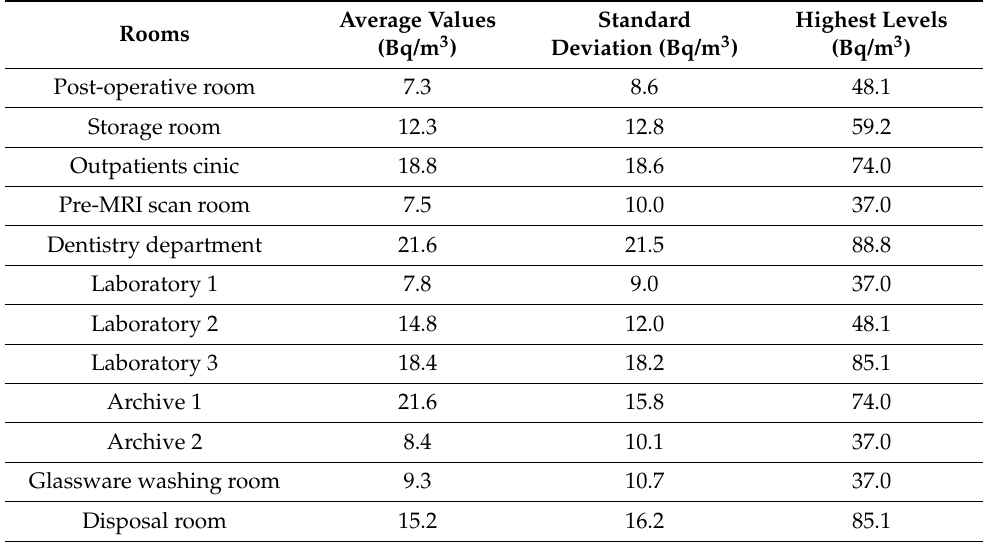
Table 3. Average values, standard deviation and highest levels of radon detected in the rooms inspected, excluding the radiotherapy